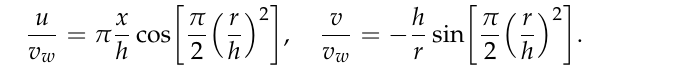
correspond to experimental data. Profiles of axial velocity predicted with the developed